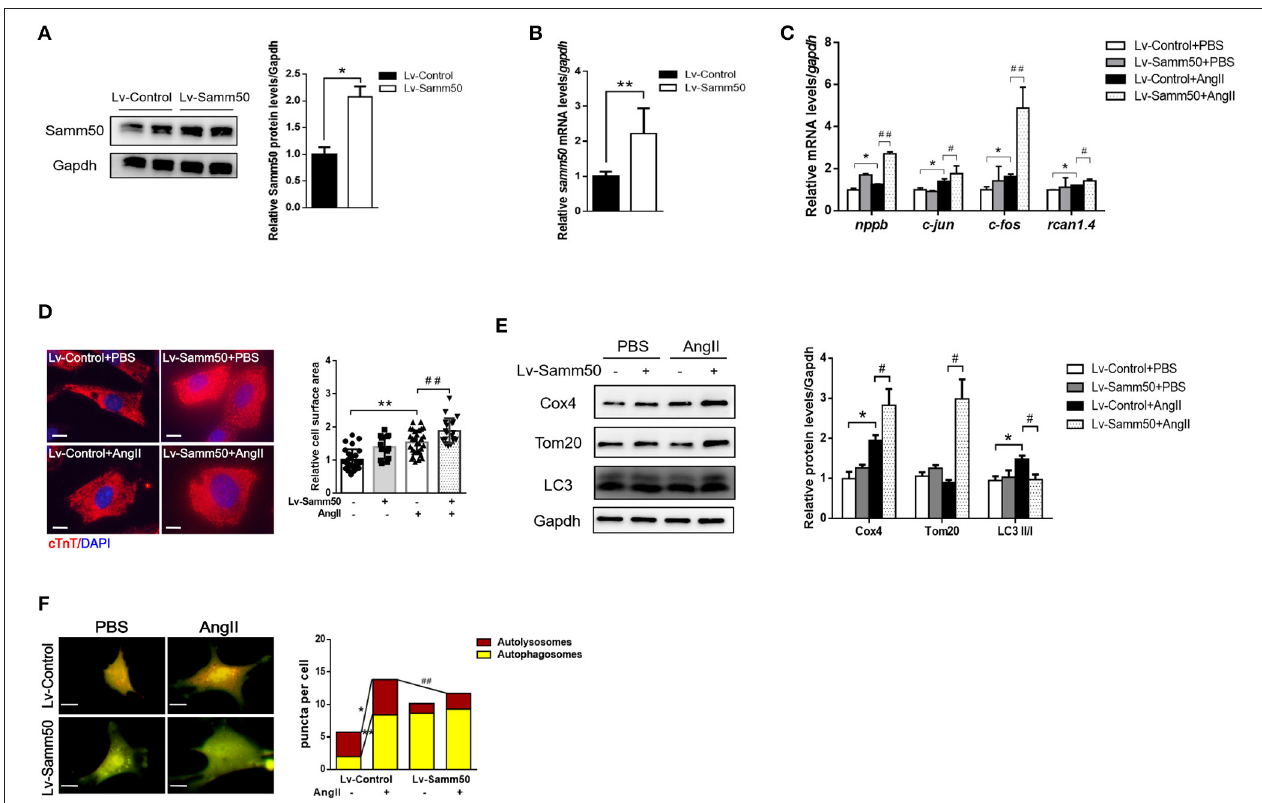
FIGURE 2 | Samm50 exacerbates cardiomyocyte hypertrophy and inhibits mitophagy. (A,B) WB (left) and qRT-PCR (right) analysis of Samm50 overexpression levels in mouse neonatal cardiomyocytes. (C) Relative mRNA levels of hypertrophic markers gene expression in Lv-Control or Lv-Samm50 cardiomyocytes with Ang II treatment. Lv-Control, lentiviral pCDH-control and Lv-Samm50, lentivirus overexpressed Samm50. (D) Representative images and calculated cell surface area of cardiomyocytes infected with indicated lentivirus in response to Ang II stimulation. Scale bars, 10 µ m. (E) Immunoblotting analysis of indicated protein levels in Lv-Control or Lv-Samm50 cardiomyocytes treated with PBS or Ang II. (F) Representative images of fluorescent LC3 puncta and statistical analysis results, and autolysosomes per cell. n = 6 for each experiment group. * P < 0.05 compared with the control group; ** P < 0.01 compared with the control group; # P < 0.05 compared with Ang II group; and ## P < 0.01 compared with Ang II group. All data are presented as mean ±